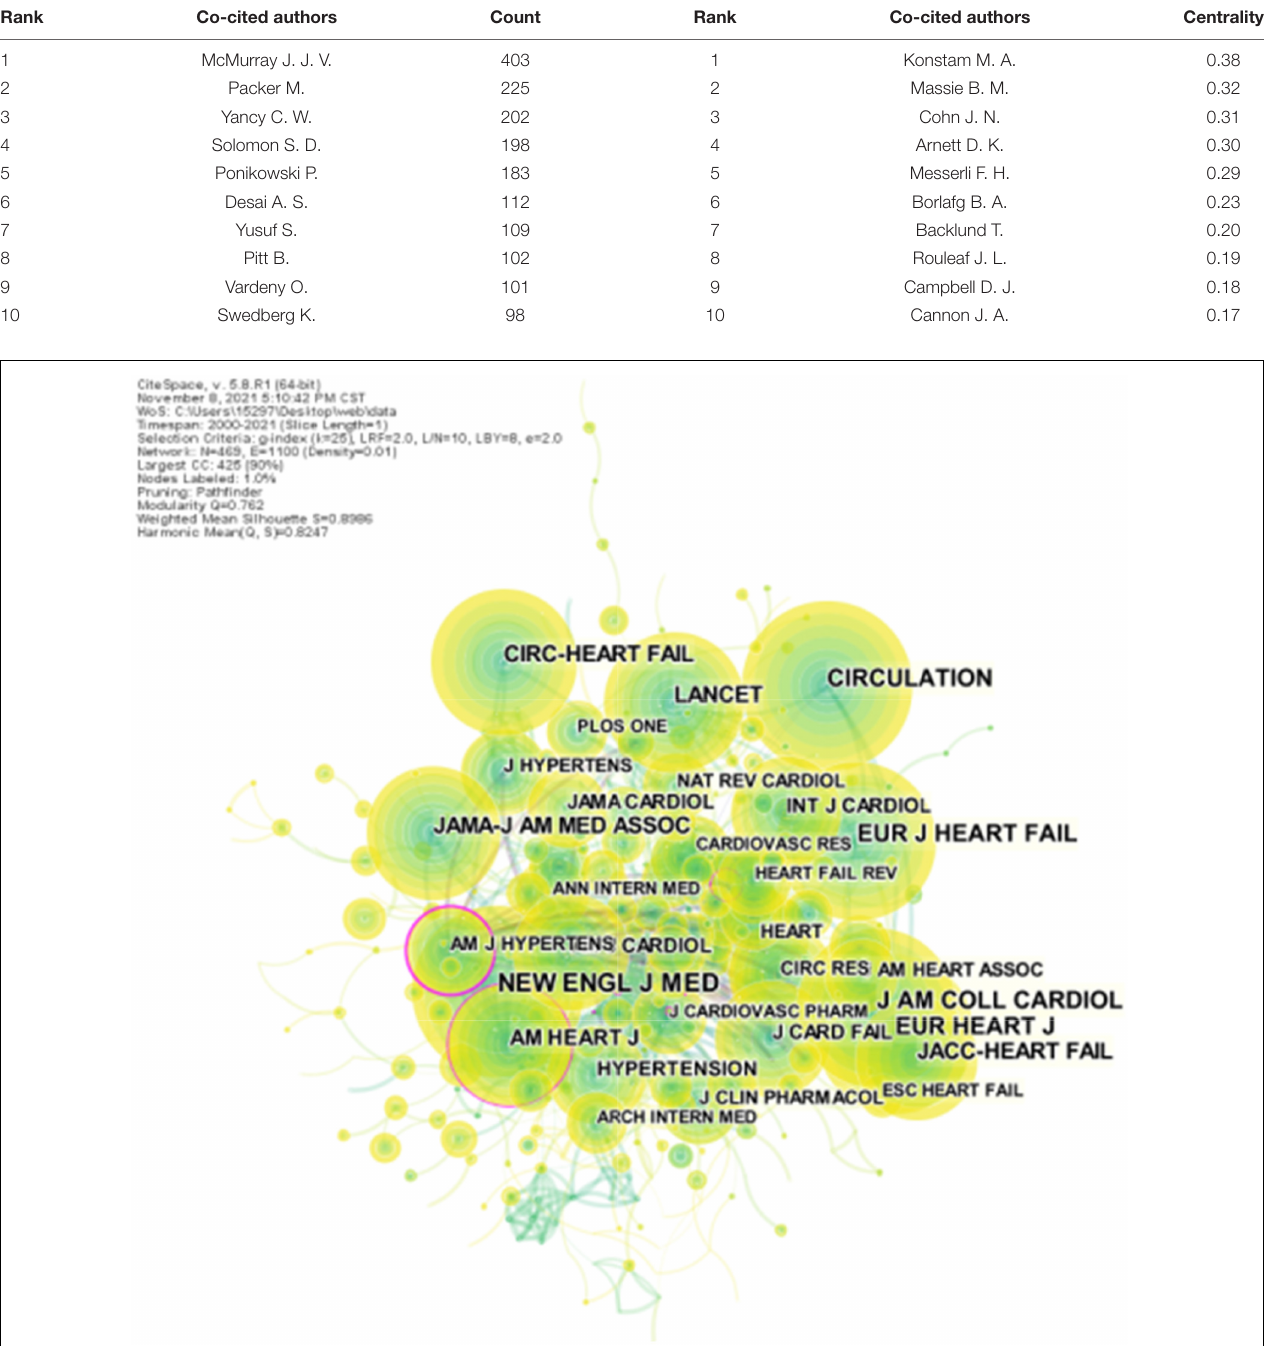
TABLE 4 | Top 10 co-cited authors in terms of number and centrality of articles related to ARNI in cardiovascular system research.